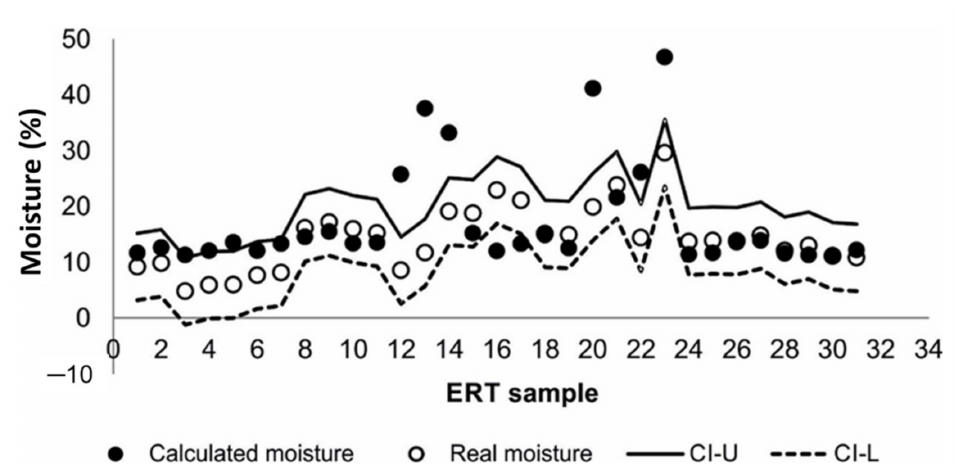
Figure 5. Relationship between real moisture and calculated moisture using the calibrated model (CI-U: upper limit of the confidence interval; CI-L: lower limit of the confidence level).